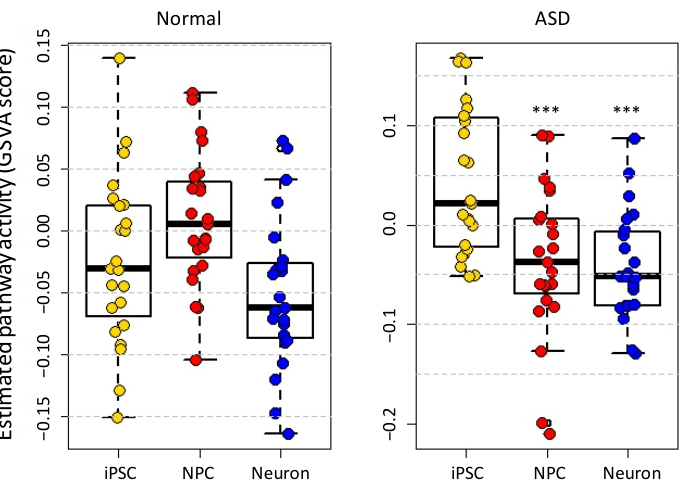
Figure 2. The estimated activity of 23 ASD-associated pathways in normal and ASD samples in three neural cell types, representing different stages of cell development. The pathway activity was assessed based on GSVA scores. In the ASD samples, the differences of GSVA scores between iPSC and NPC ( p -value = 7.64 × 10 − 4 ), as well as between iPSC and neuron cells ( p -value = 7.11 × 10 − 5 ) were statistically significant. *** p < 0.001, two-tail Student’s t